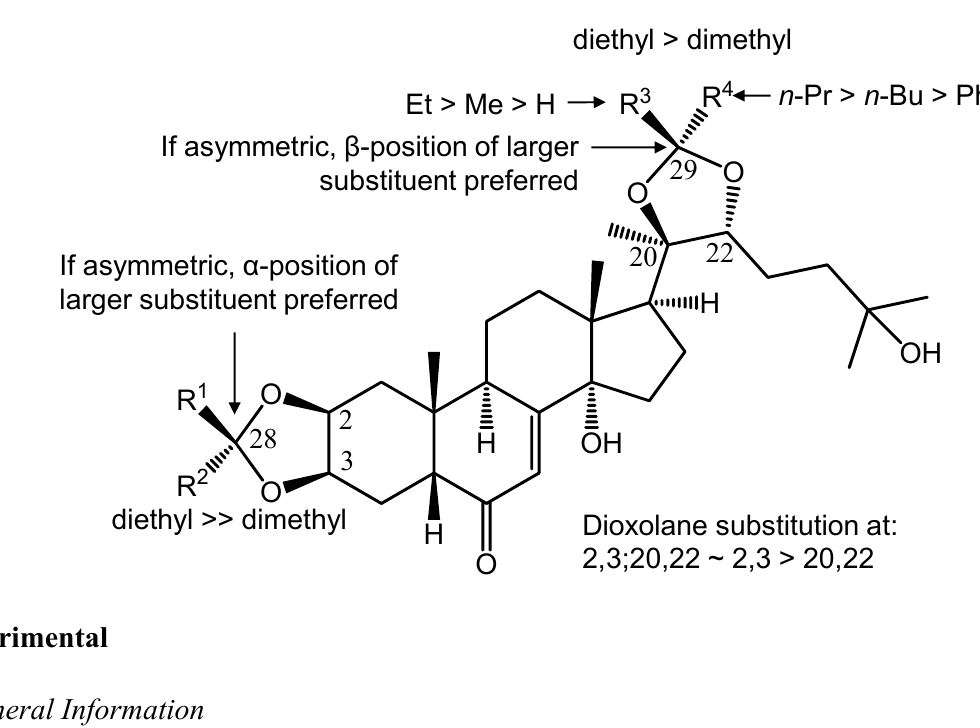
Figure 4. SAR summary for compounds 1 – 33 . “Greater than” symbols denote stronger synergistic activities, i.e. , lower weighted average CI values when applied together with